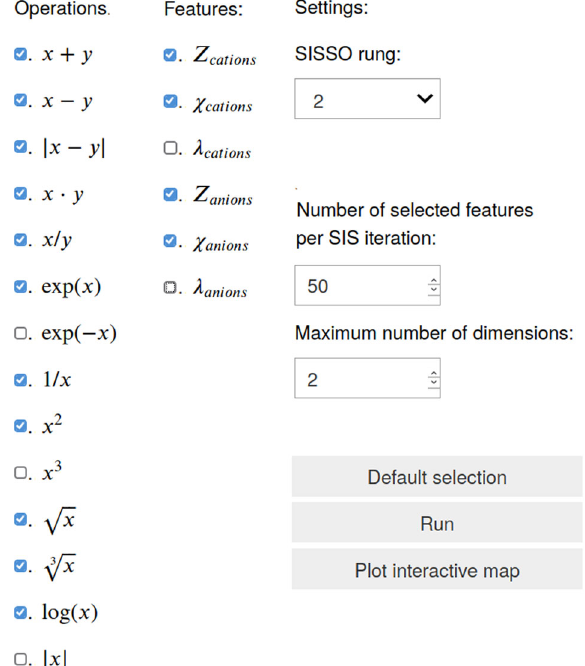
Fig. 4 Graphical input interface for the SISSO training of tetradymite-materials classi fi cation. The snapshot is taken from the ‘ Discovery of new topological insulators in alloyed tetradymites ’ notebook.